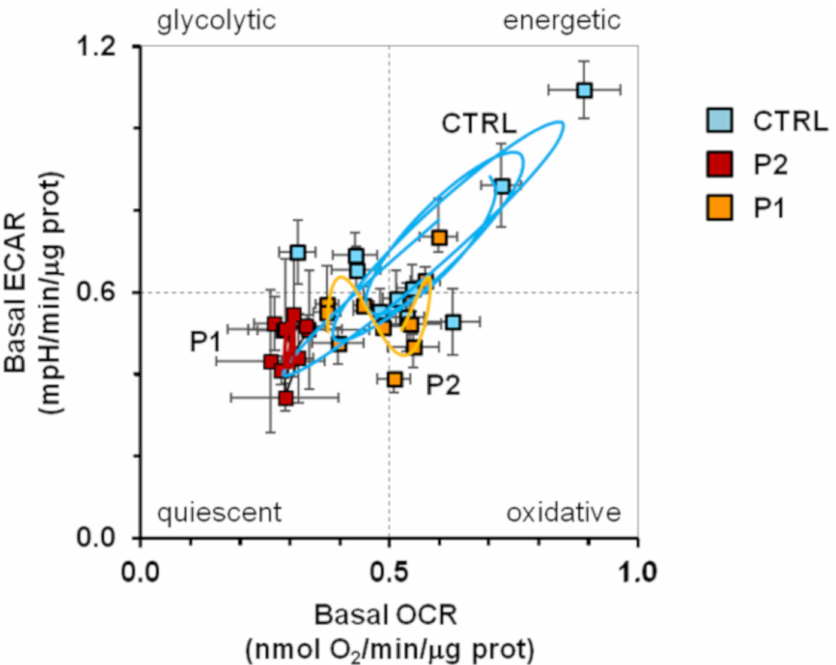
Figure 5. Bioenergetic profile in synchronized intact fibroblasts. The graph displays the energy map obtained plotting the resting extracellular acidification rate (ECAR) and oxygen consumption rate (OCR) values obtained from data shown in Figure 4 for normal fibroblasts (CTRL, light blue square), and PD patient fibroblasts (P1, red square; P2, orange square); the continuous lines are computed merging the best-fitting COSINOR curves for OCR and